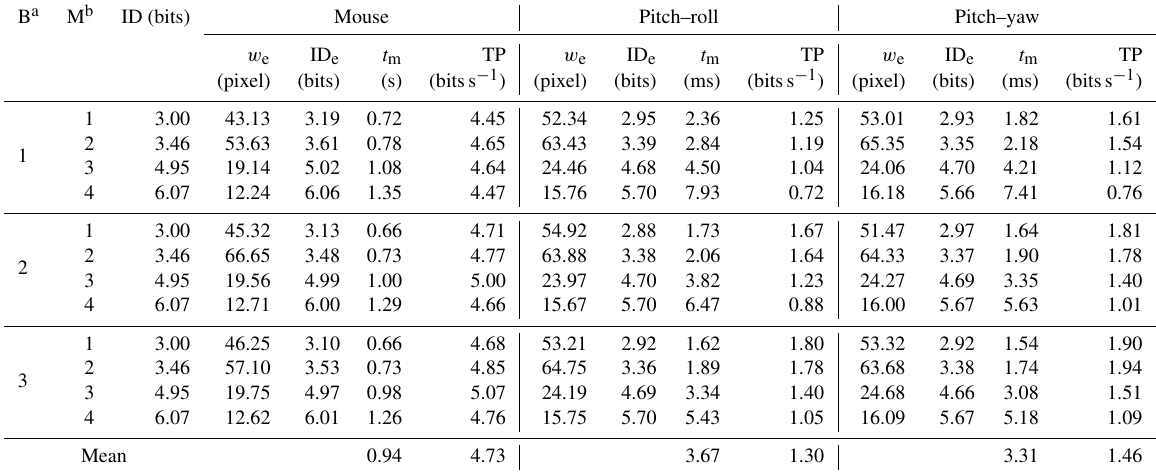
Table 2. Experiment results (in detail). B a